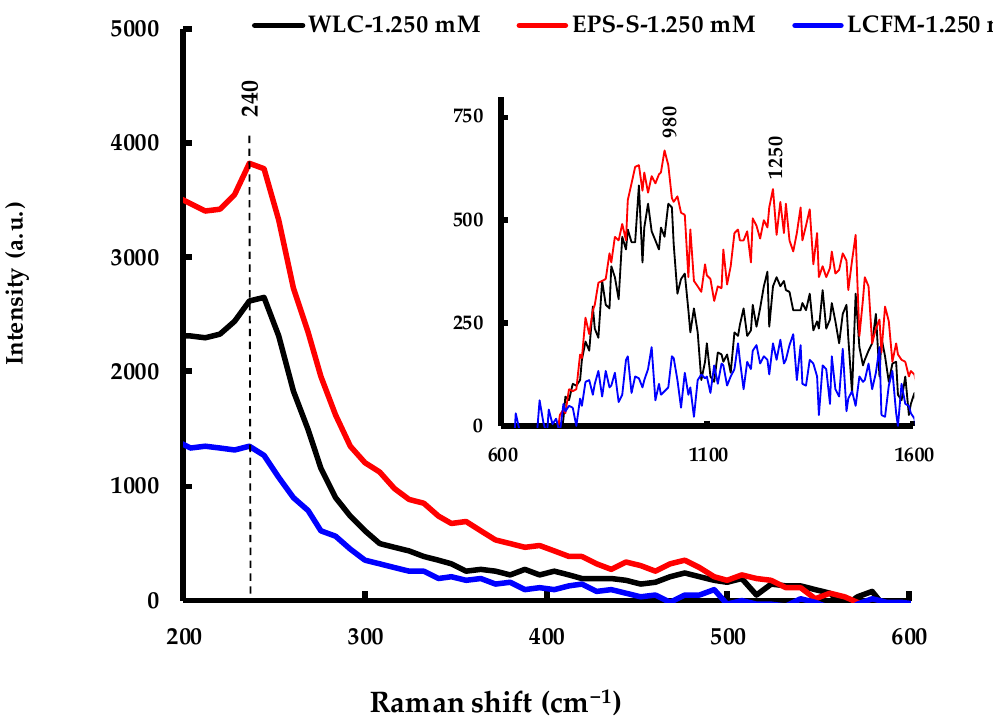
Figure 11. Raman spectroscopy on the AgNPs produced by WLC-1.250 mM, EPS-S-1.250 mM and LCFM-1.250 mM.